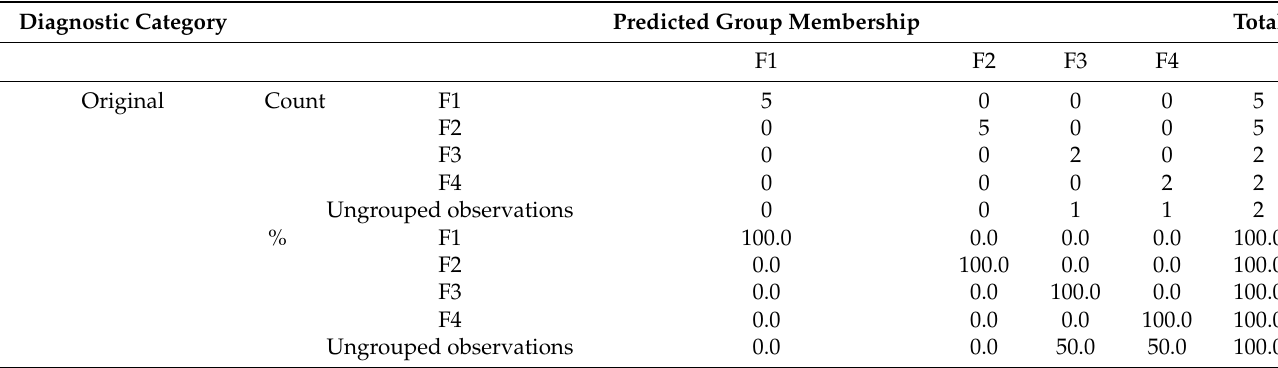
Figure 7. Groupings of tea farmers using Functions 1 and 2. Table 5. Classification results of the Fisher discriminant